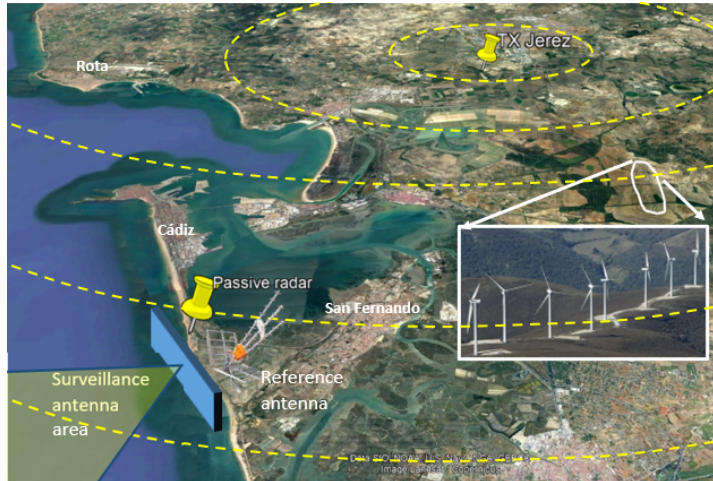
Figure 2. General view of the radar scenario with its main